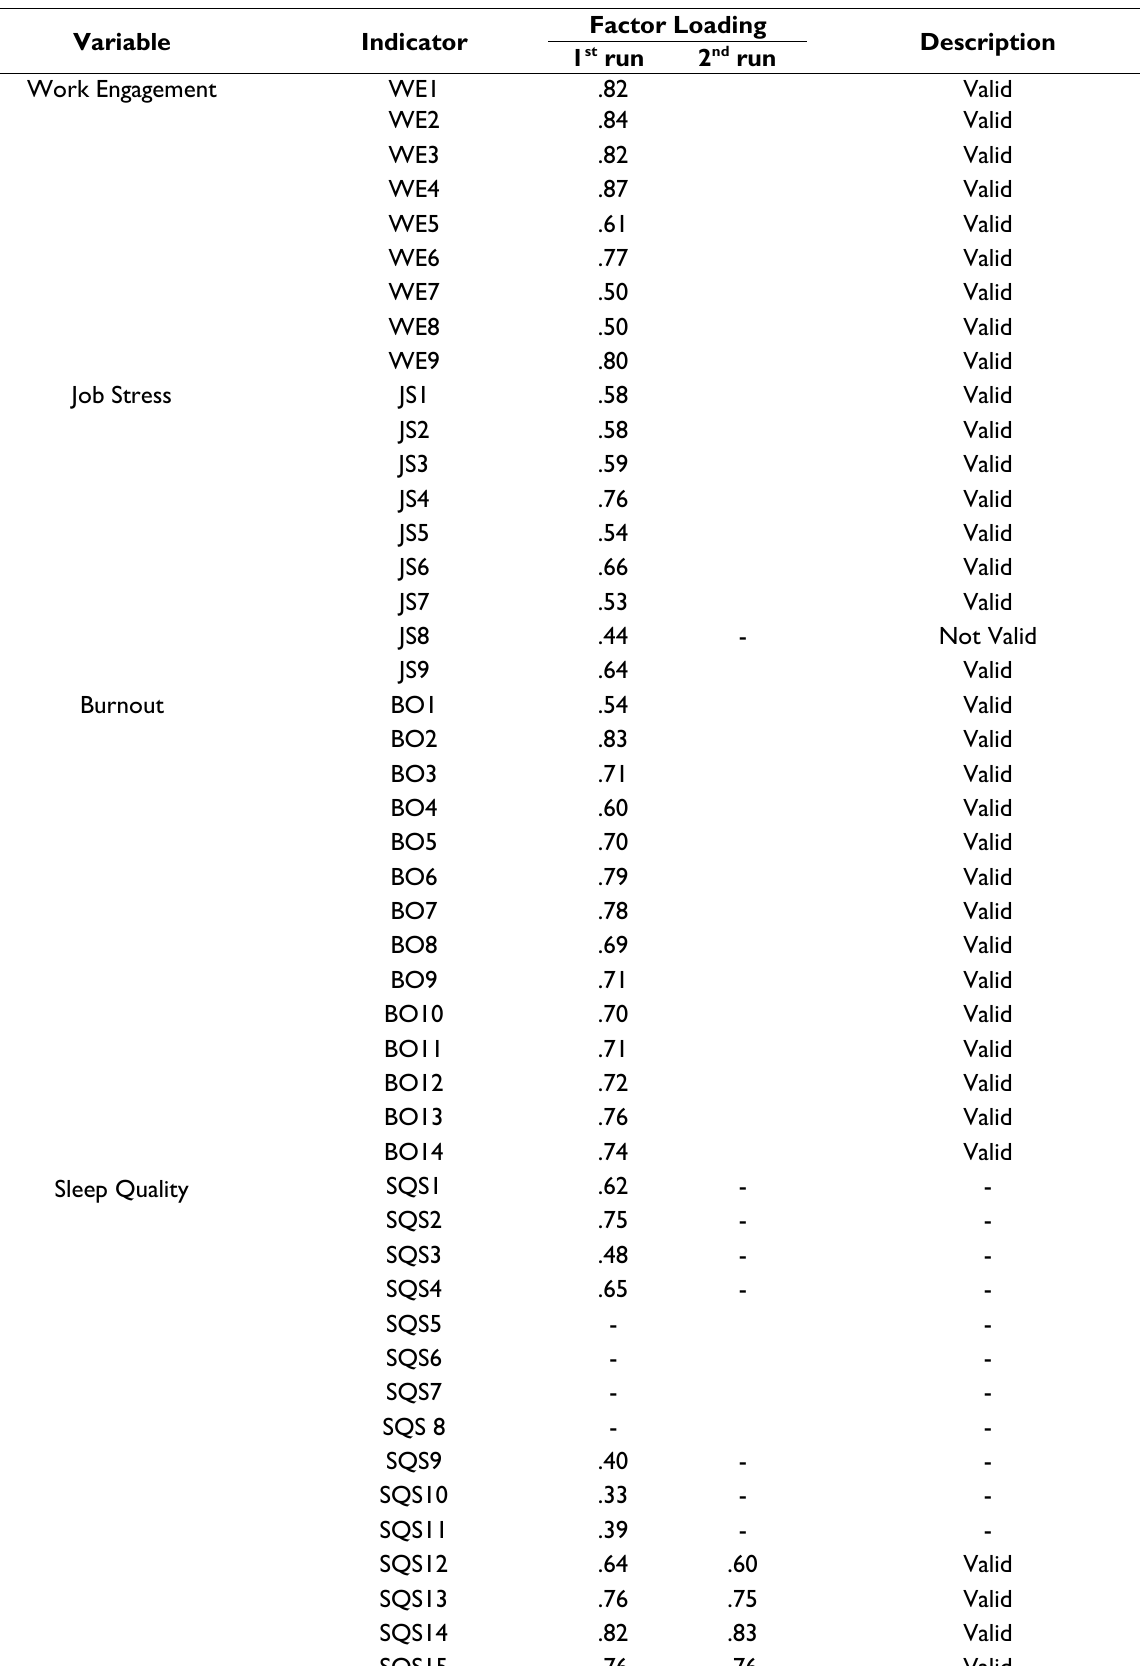
Table 3. Work Engagement, Job Stress and Burnout Factor